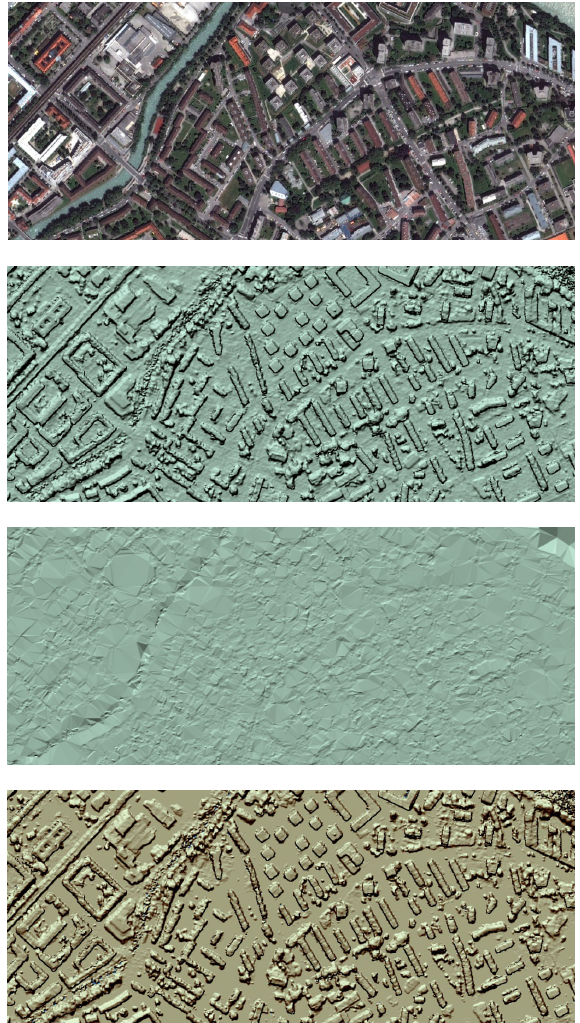
Figure 8. Suburban subset. Shown are ortho image, DSM, extracted DTM and corresponding